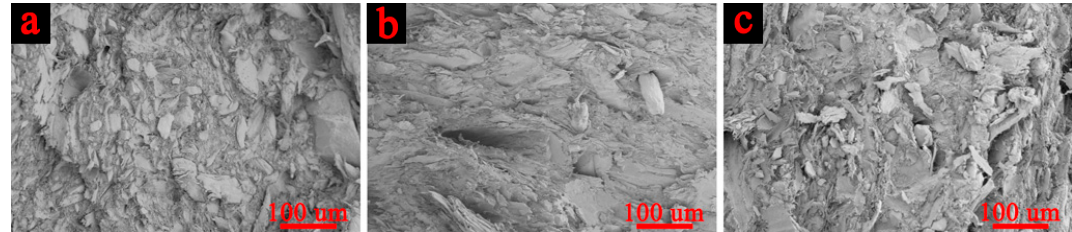
Figure 7. The interface morphology of WF/Re-HDPE composites with different WF contents (( a ) 50% WF/Re-HDPE, ( b ) 60% WF/Re-HDPE, and ( c ) 70% WF/Re-HDPE).